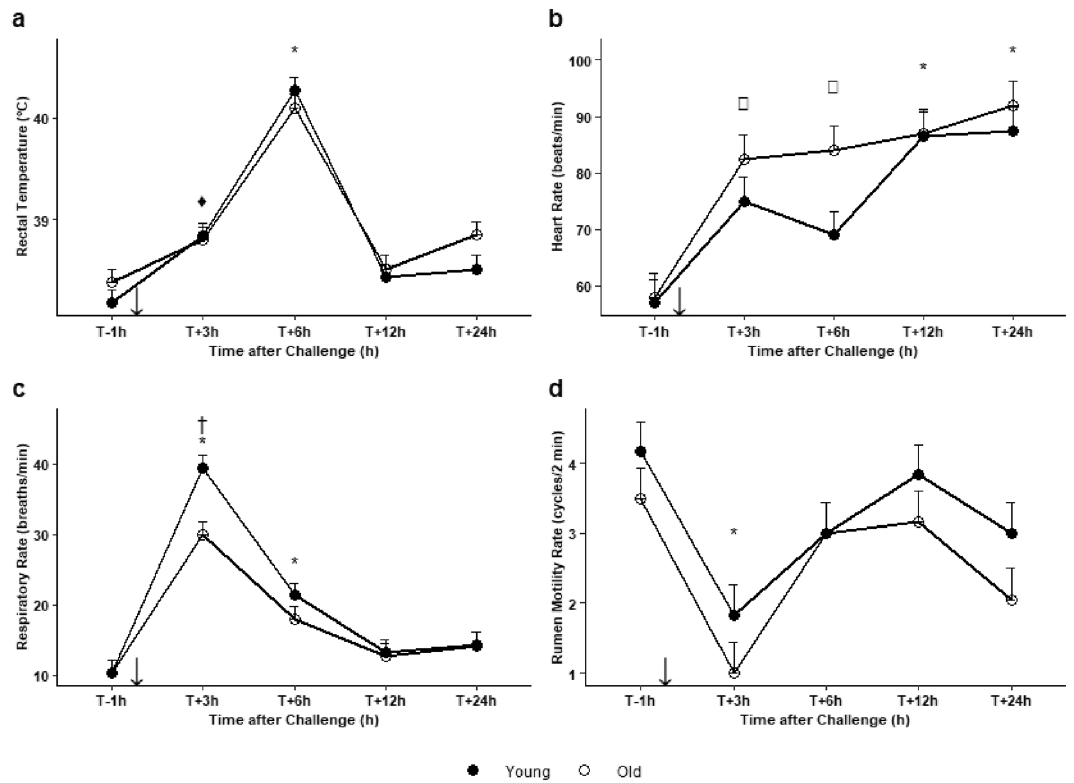
Figure 6. Changes in ( a ) rectal temperature, ( b ) heart rate, ( c ) respiratory rate, and ( d ) rumen motility rate in 6 old (white dots) and 6 young (dark dots) Holstein cows one hour before (T−1 h) and at 3, 6, 12 and 24 h after intravenous injection of LPS (0.5 µg/kg of BW) (black arrow). Data are presented as least squares means (± SE). Means flagged with * indicate significant differences between the values obtained at a given time-point and baseline value obtained at T−1 h regardless of age, with ♦ for young cows only and □ for old cows only ( p ≤ 0.05). Means flagged † indicate significant difference between old and young cows at a specific time-point ( p ≤ T−1 h (58 ± 4.2 beats/min), HR increased significantly from T + 3 hpi (82.5 ± 4.2 beats/min, P = 0.007) and con- tinued to increase up to T + 24 hpi (92 ± 4.2 beats/min). In young cows, compared to T−1 h (57 ± 4.2 beats/ min), HR increased significantly and reached a plateau until the end of the experimental period (86.5 ± 4.2 at T + 12 hpi, P = 0.0006, 87.5 ± 4.2 beats/min at T + 24 hpi, P = 0.0003). In both groups, compared to T−1 h (young cows: 10.3 ± 1.8 breaths/min; old cows: 10.3 ± 1.8 breaths/min), RR increased significantly to peak at T + 3 hpi (39.3 ± 1.8 breaths/min, P < 0.0001 for young cows, 30.0 ± 1.8 breaths/min, P < 0.0001 for old cows). At T + 3 hpi, RR was lower in the old cows than young cows ( P = 0.02). Compared to T−1 h (young cows: 4.2 ± 0.4 contrac- tions/2 min; old cows: 3.5 ± 0.4 contractions/2 min), RMR decreased significantly at T + 3 hpi and similarly in both groups of cows (1.8 ± 0.4 contractions/2 min, P = 0.003 for young cows and 1.0 ± 0.4 contractions/2 min, P = 0.001 for old cows). The values returned to baseline from T + 12 hpi. Miscellaneous clinical signs (dyspnoea and tremor) were noted in 7 cows at T + 6 hpi (Table 2; p = 0.02, McNemar test), none of which had shown mis- cellaneous clinical signs at T−1 h. All blood parameters changed significantly (Fig. 7 plus detailed output of the models in Supplementary Table S2). Compared to T−1 h (young cows: 37.2 ± 1.3 ng/mL; old cows: 24.0 ± 1.3 ng/mL), plasma cortisol con- centration increased significantly and peaked at T + 3 hpi (144.5 ± 1.3 , P = 0.0003 for young cows, 169.8 ± 1.3, P < 0.0001 for old cows) and fell back to initial baseline level by T + 12 hpi for young cows and T + 24 hpi for old cows. There was a similar significant elevation to peak at T + 3 hpi compared to T−1 h for plasma IL1-β (20.7 ± 2.8 vs. 3.5 ± 2.8 pg/mL, P = 0.0001 for young cows and 21.5 ± 2.8 vs. 8.4 ± 2.8 pg/mL, P = 0.005 for old cows), IL-6 (377.6 ± 1.6 vs. 3.5 ± 1.6 pg/mL, P < 0.0001 for young cows and 548.3 ± 1.6 vs. 7.0 ± 1.6 pg/mL, P < 0.0001 for old cows), and TNF-α (33 884.4 ± 1.5 vs. 85.1 ± 1.5 pg/mL, P < 0.0001 for young cows and 44 668.4 ± 1.5 vs. 223.9 ± 1.5 pg/mL, P < 0.0001 for old cows) and the values had returned to baseline at T + 24 hpi except for IL-6 in old cows which remained significantly higher than at T−1 h (40.6 ± 1.6 pg/mL, P = 0.03). There were no significant between-age differences in plasma cortisol and cytokine concentrations. Plasma haptoglobin con- centration was increased at T + 24 hpi in both young cows (237.9 ± 14.9 vs. 0.0 ± 14.9 mg/mL, P < 0.0001) and old cows (172.1 ± 14.9 mg/mL vs. 0.0 ± 14.9 mg/mL, P < 0.0001) but the increase was significantly less marked in old cows than young cows ( P = 0.04).